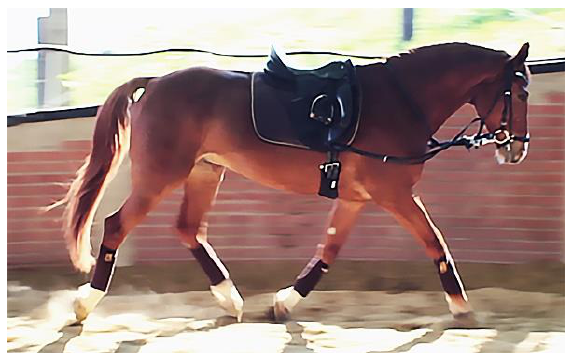
Figure 1. Head-neck-position during the unridden test.